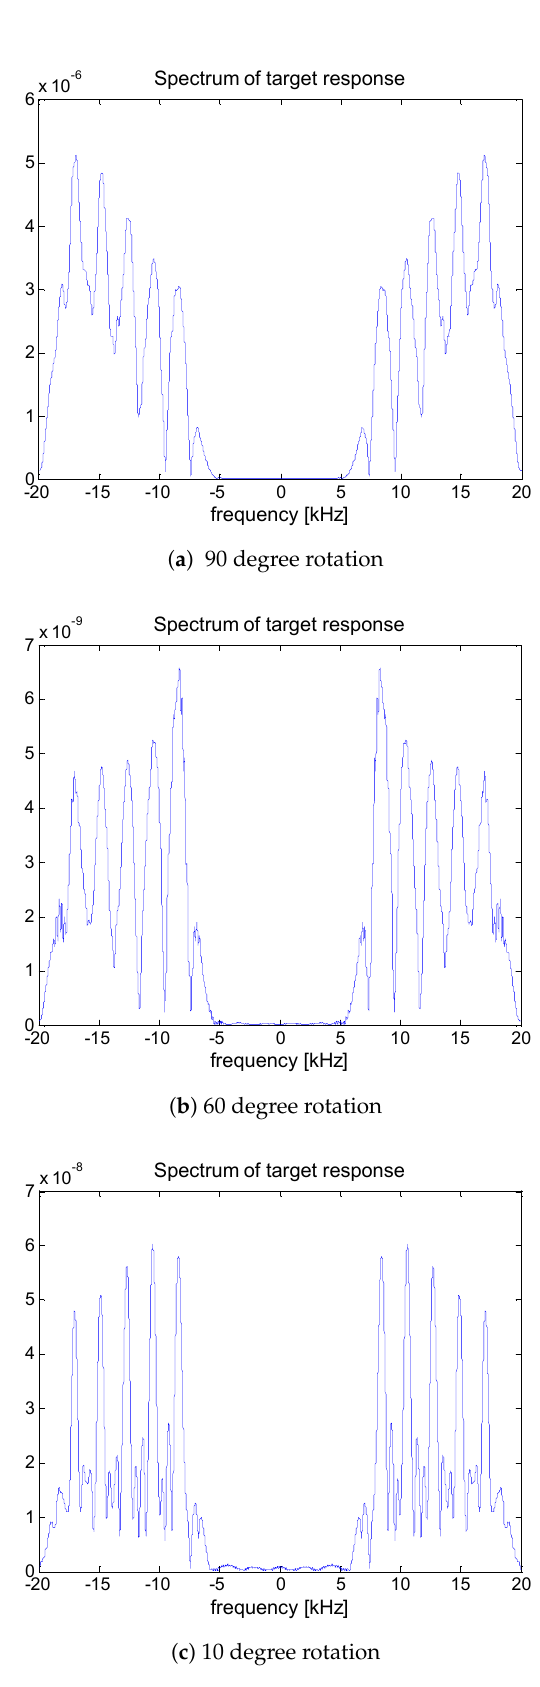
Figure 4. Magnitude spectra of the target response for various rotation angles for an linearly frequency modulated (LFM) signal of 13 kHz center frequency and 14 kHz